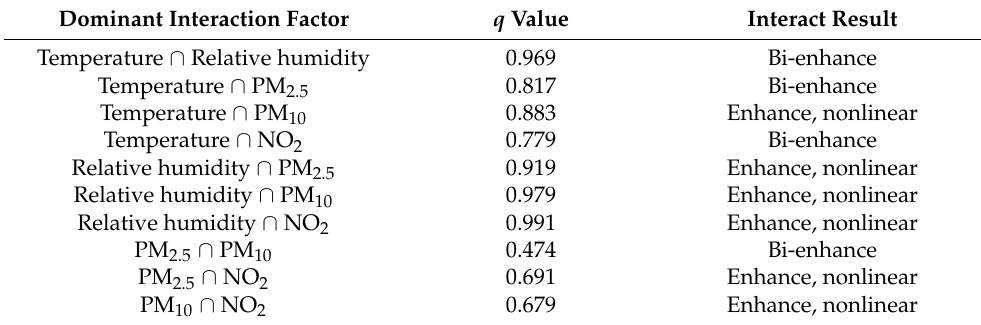
Table 3. Results of interaction detector in northern cities.